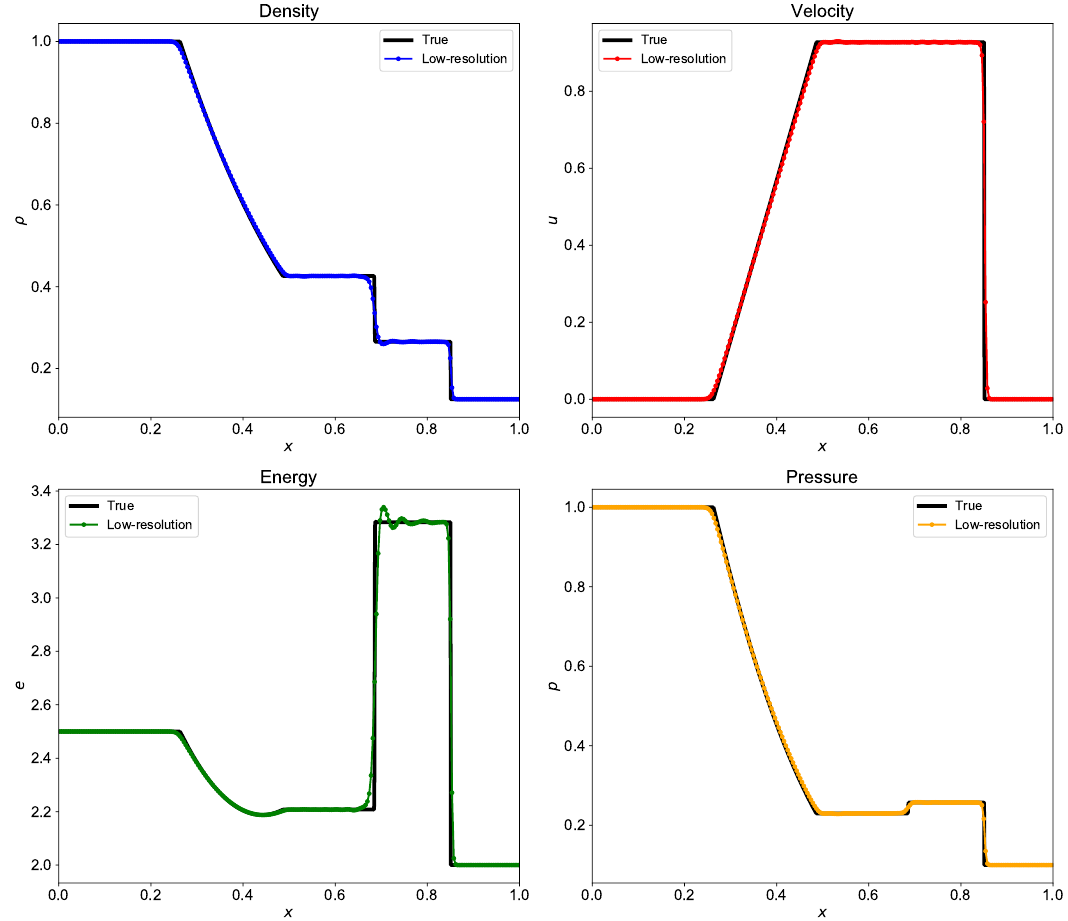
Figure 14. Evolution of density, velocity, energy, and pressure at t = 0.2 for the shock tube problem computed using Riemann solver based on Rusanov scheme. The true solution is calculated with N = 8192 grid resolution with ∆ t = 0.00005 and the low-resolution results are for N = 256 grid resolution with ∆ t =